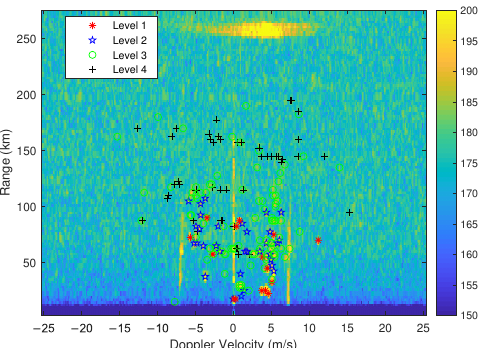
Figure 7. Plot quality evaluation